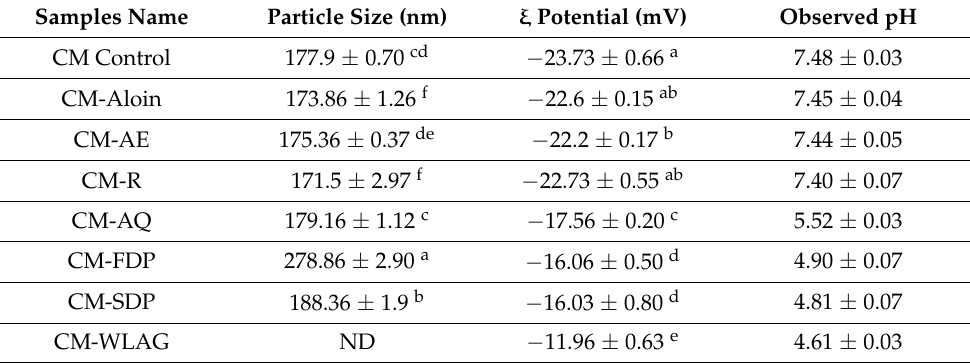
Values are mean and standard deviations from triplicate data. The data was analysed by one-way ANOVA and Tukey’s post hoc HSD tests. The different letters in superscript (a, b, c, ab, d, cd, e, de, f) within rows indicate statistically significant differences ( p <